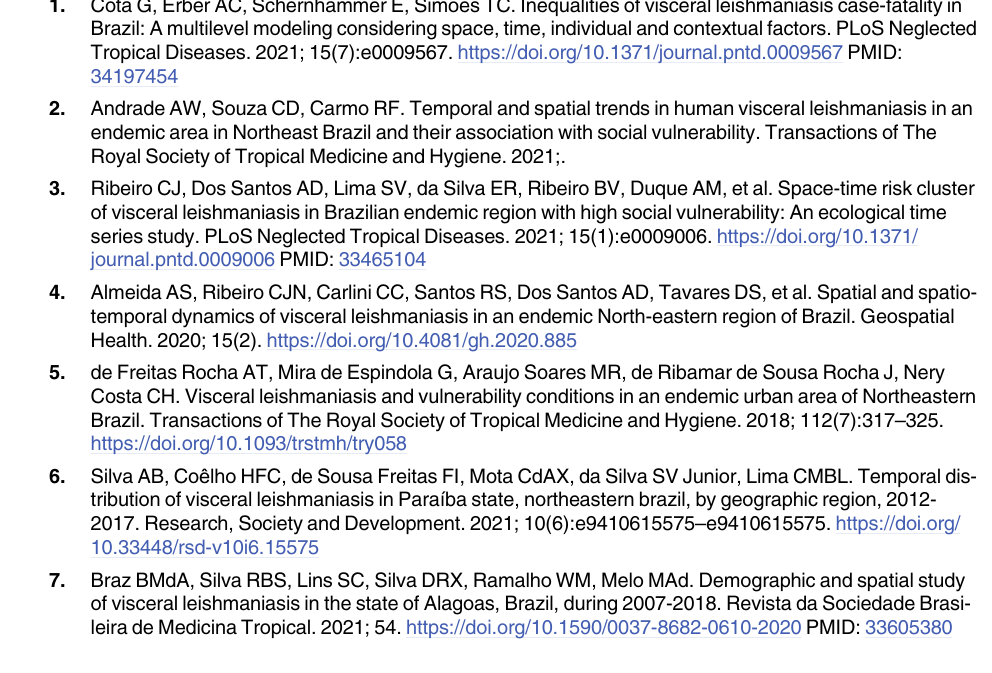
S1 Table. Factor loadings for the three factors estimated in the Exploratory Factor Analy-